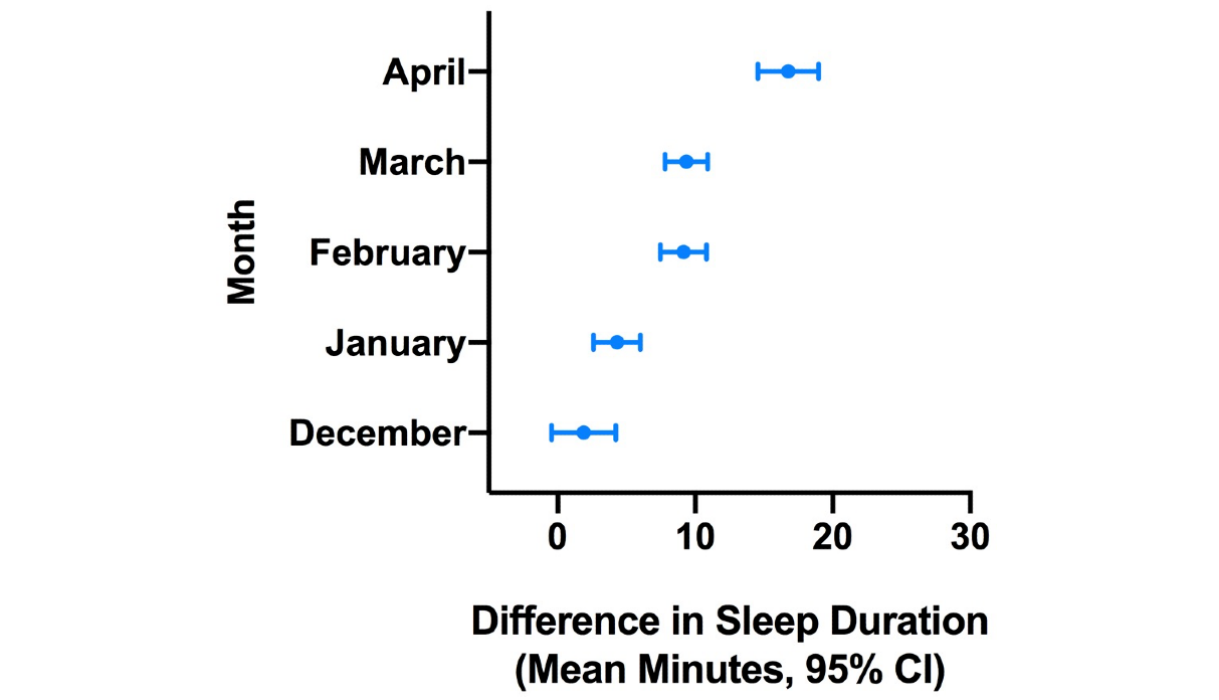
Figure 8. Difference in estimated sleep duration during the COVID-19 pandemic compared to the same month in the previous year in